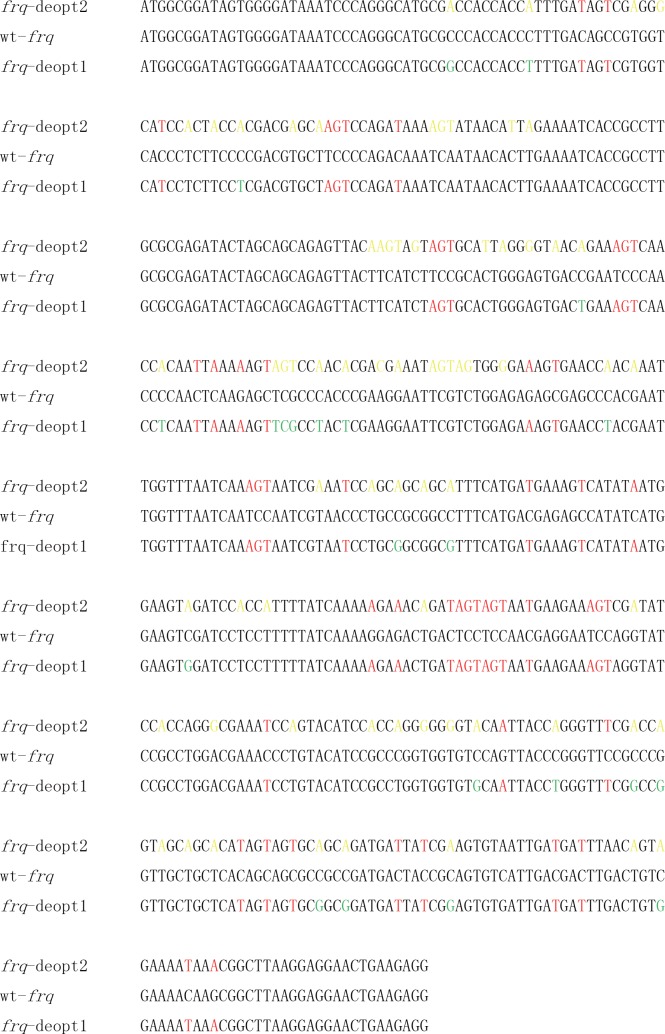
DNA sequences of 5’ end of the frq open reading frame region for the indicated constructs.Nucleotides mutated only in frq-deopt1 are shown in green, nucleotides mutated only in frq-deopt2 are shown in yellow; nucleotides mutated both in frq-deopt1 and frq-deopt2 are shown in red.